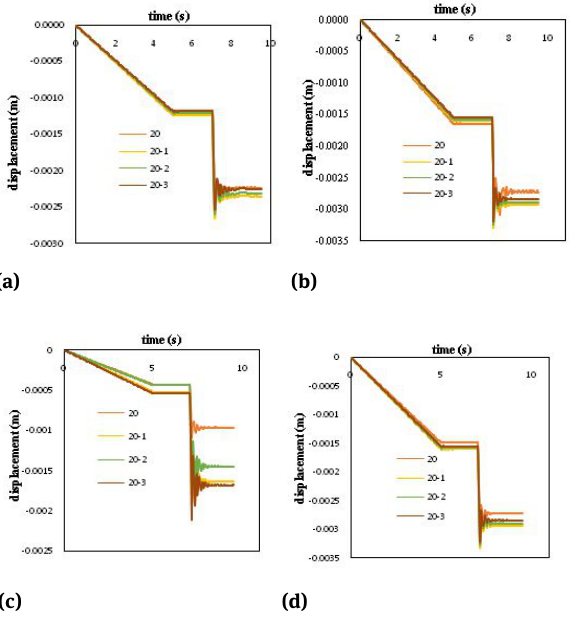
Figure 5: Nonlinear dynamic curves of 20-story structures, (a) D1- 10 th Floor; (b) D3-10 th Floor; (c) G3-10 th Floor; (d) D3-16 th Floor